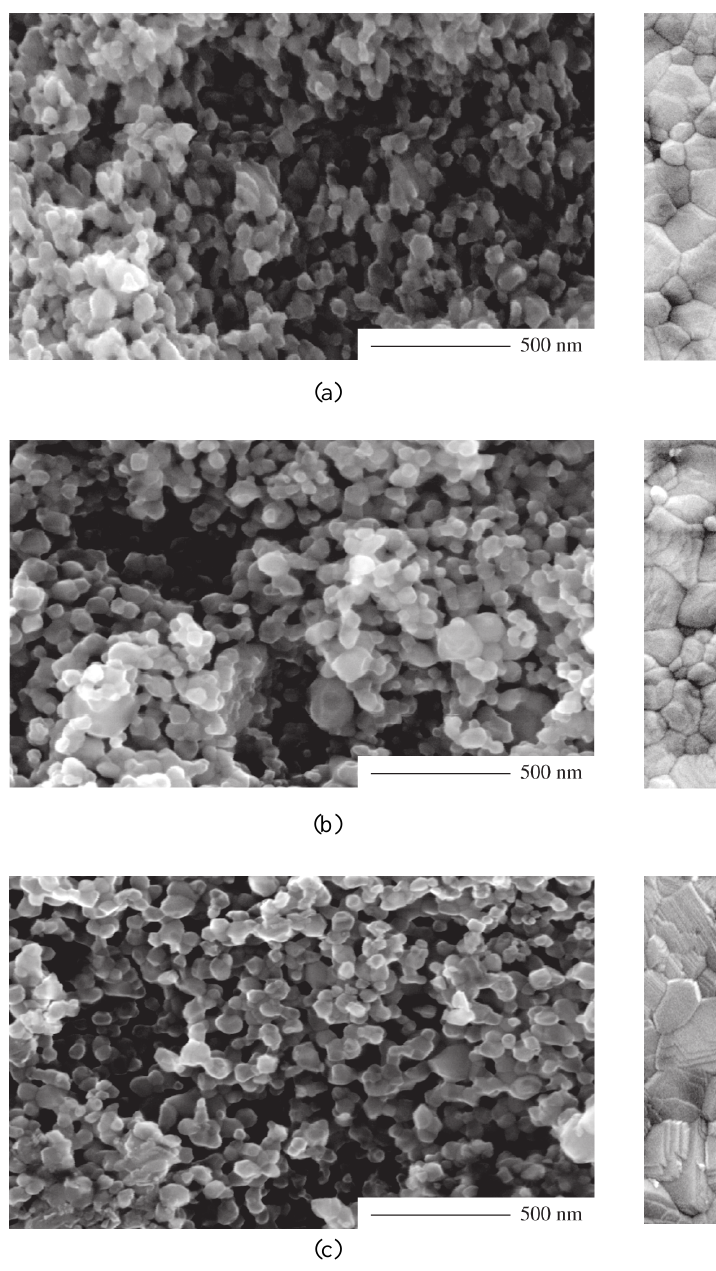
Figure 3. SEM Micrographs of a) C03, b) C05, c) C07 at 800 °C, with a CHR of 5